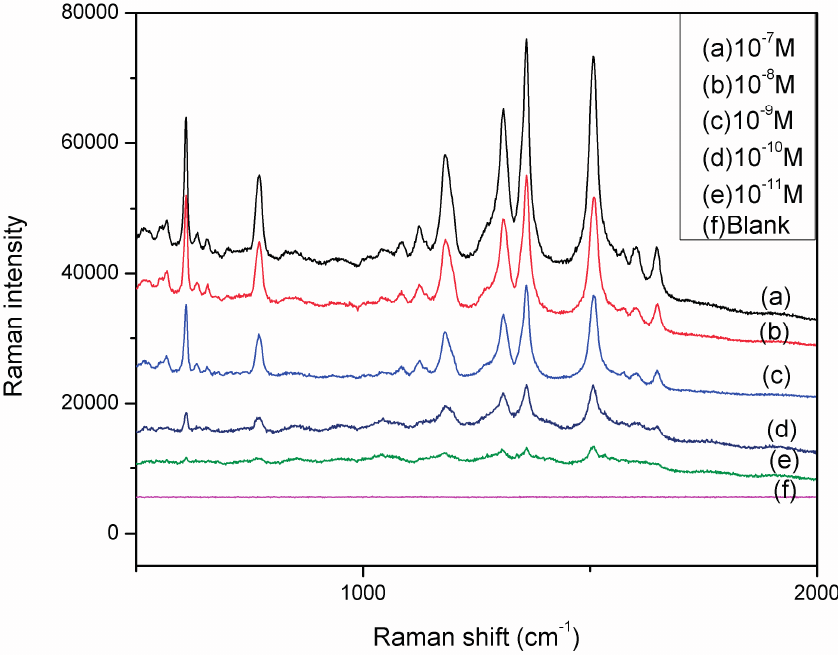
Figure 7. SERS spectra of R6G in water of various concentrations on Ag NPs@AuFON hybrid structure.